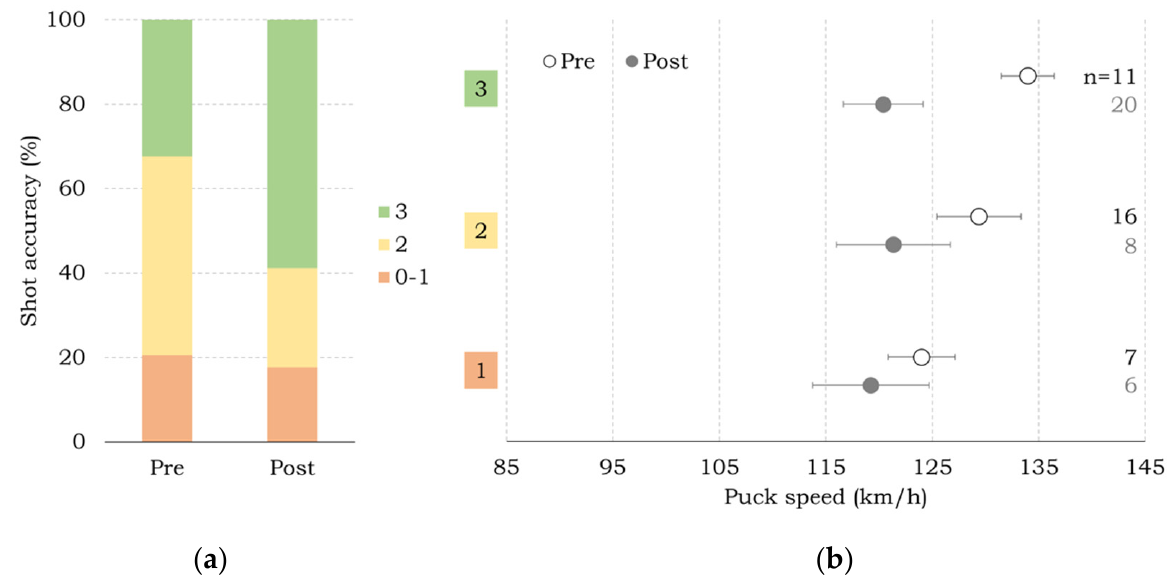
Figure 1. Slap shot accuracy and associated puck speed on three attempts before (Pre) and after (Post) the IHCT: ( a ) Relative occurrence of successful goal shots; ( b ) Puck speed with the number of athletes within the respective subgroup. Values are mean with 90% confidence intervals.